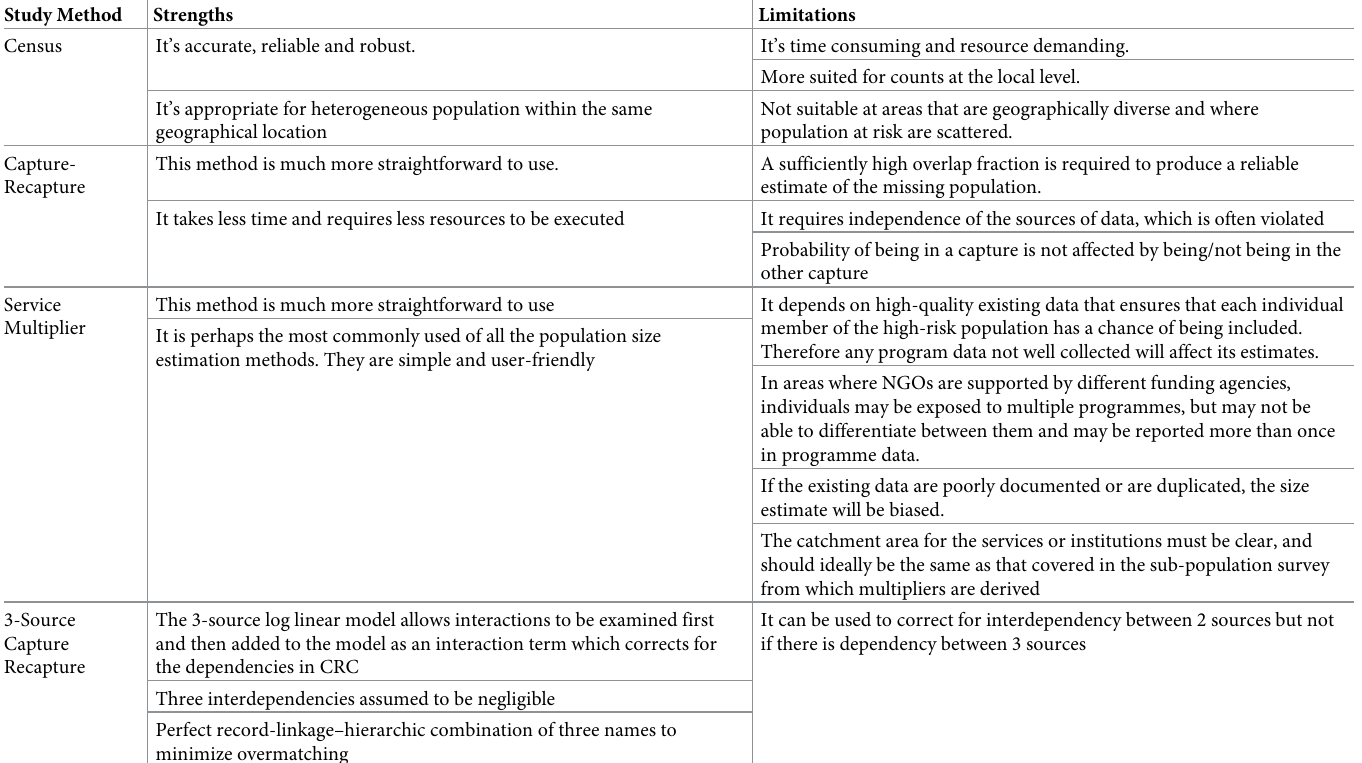
Table 5. Strengths and limitations of the methods used to estimate the FSW